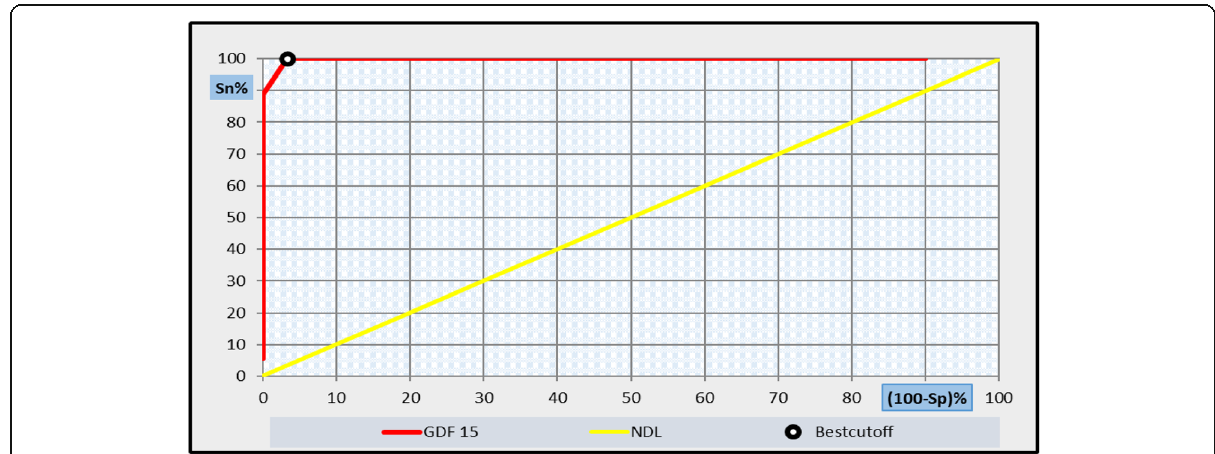
Fig. 6 Receiver operating characteristic curve (ROC) analysis showing the diagnostic performance of GDF-15 for discriminating patients with subgroup-1 (F0 – 1) from those control with area under the curve (AUC) =